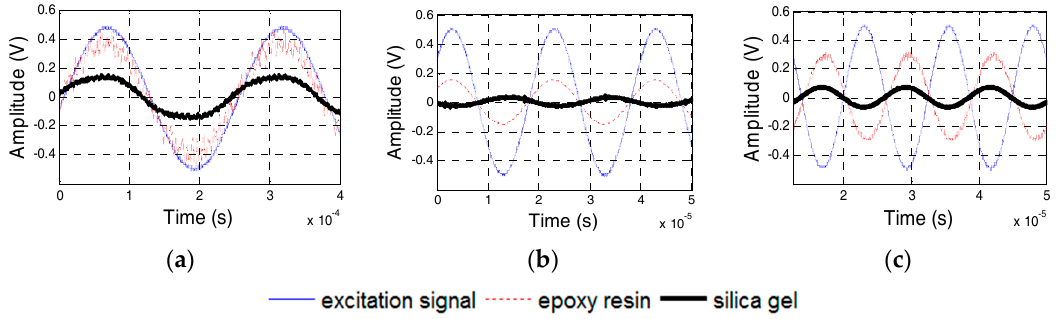
Figure 20. PZT transducer signal of Specimen 3. ( a ) 4 kHz Excitation Frequency; ( b ) 30 kHz Excitation Frequency; and, ( c ) 55 kHz Excitation Frequency.